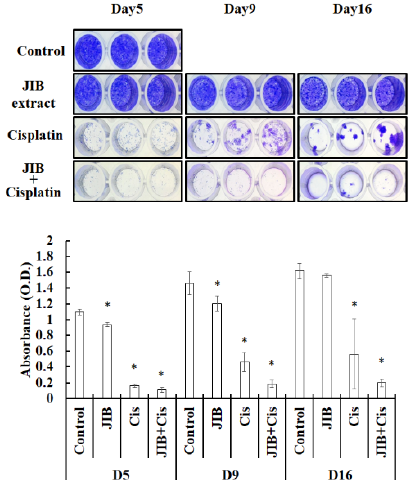
Figure 6. JIB extract plus cisplatin inhibited regrowth. Cells were treated with JIB extract, cisplatin or a combination of JIB extract and cisplatin for 5, 9 and 16 days, and fresh drugs were added every three days. After treatment, cells were stained with 0.1% crystal violet and photographed. The crystals were dissolved in 10% acetic acid, and the O.D. (Optical density) at 590 nm was measured. *—significant difference between the control and drug treatment groups. ( p < 0.05).